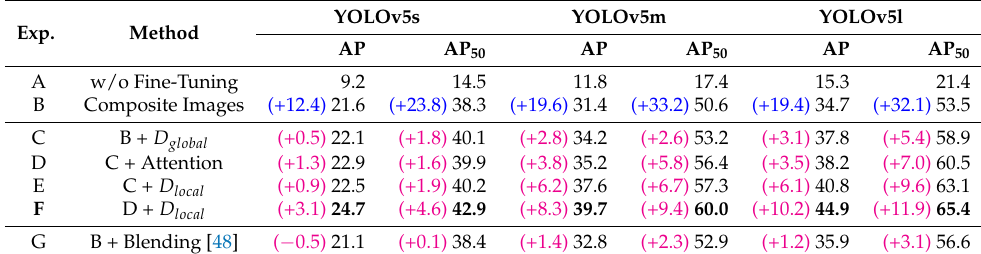
Figure 6. Visualization of victim detection. Five samples ( a – e ) are shown with red rectangles denoting detected victims. The first row is the ground-truth, and the second row is the default COCO pre-trained YOLOv5l model. The third row and the fourth row are the models fine-tuned on our composite images and harmonious images, respectively. Due to copyright and privacy issues we only show our own images. Table 2. Ablation study of our deep harmonization network modules. The best results are highlighted in bold